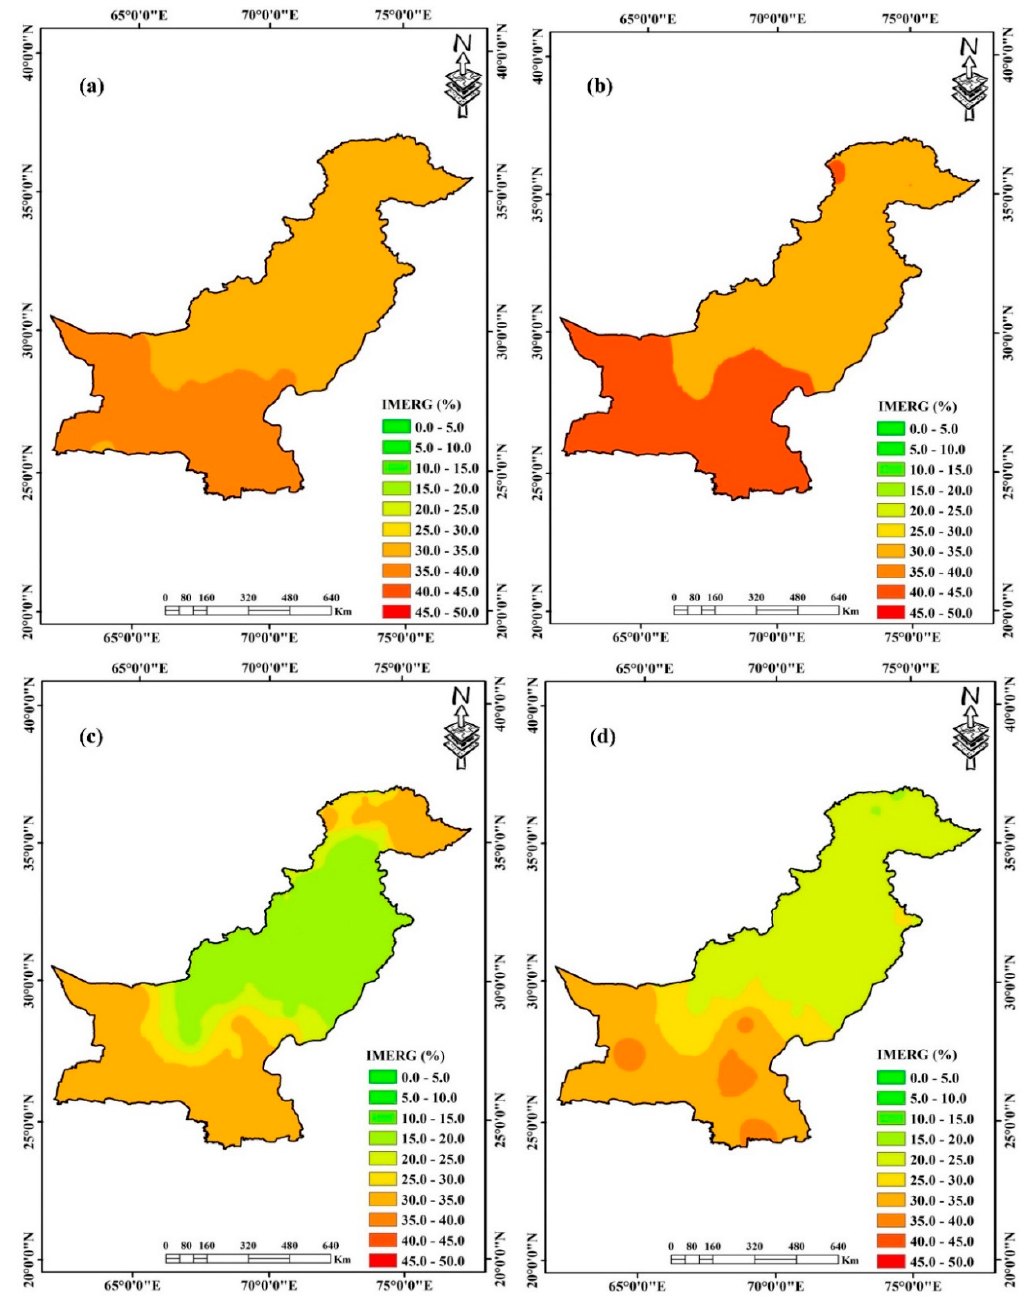
Figure 4. Spatial distribution of average Global Precipitation Measurement (GPM)-based Integrated Multi-Satellite Retrievals for GPM (IMERG) seasonal weights, across Pakistan from 2007 to 2018. ( a ) Pre-monsoon; ( b ) Monsoon; ( c ) Post-monsoon; ( d ) Winter. The seasonal distribution of TMPA in combination with ERA-Interim (hyper-arid region marked with red boundary) are presented in Figure 5. Similar to IMERG, TMPA dominated the pre-monsoon and monsoon seasons, while relatively poor weights were depicted during post-monsoon and winter